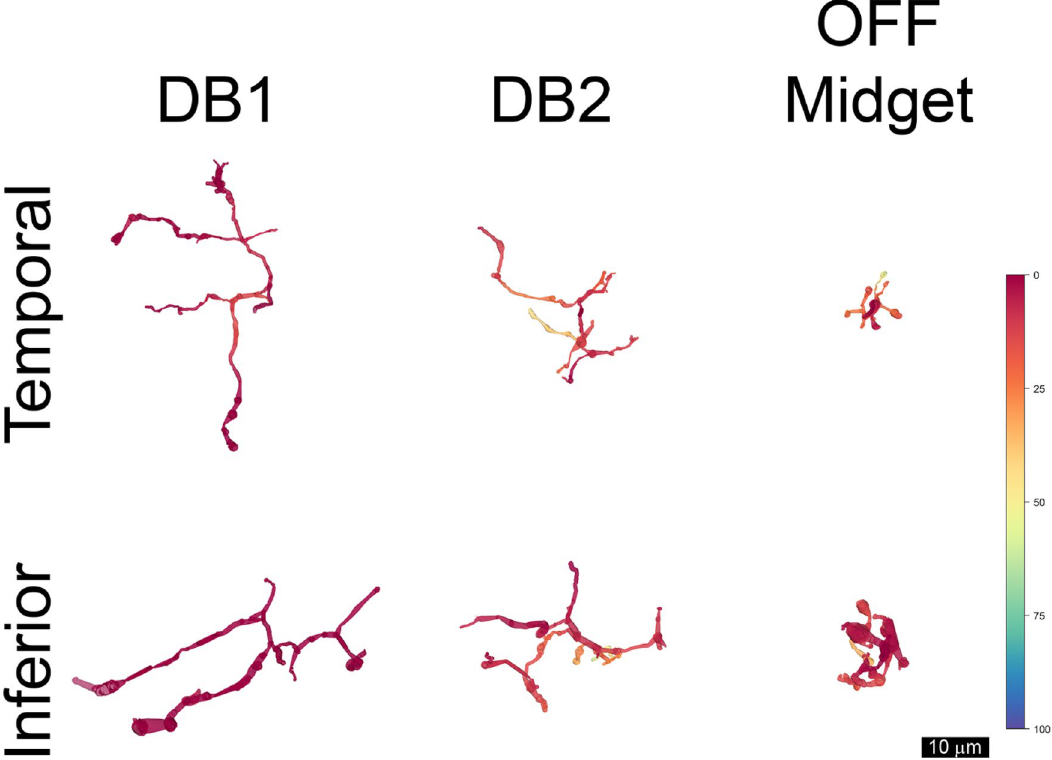
Figure 7. OFF bipolar cell synapses onto displaced M1 ganglion cells in the temporal (t) and inferior (i) volumes. Note that DB1 axon terminals ramified in S1 (red) and that DB2 and OFF midget axon terminals also ramified in S2 (orange and yellow). OFF midget = 44052t, DB2 = 44029t, DB1 = 44289t. DB1 = 48234i, DB2 = 48197i, OFF midget =